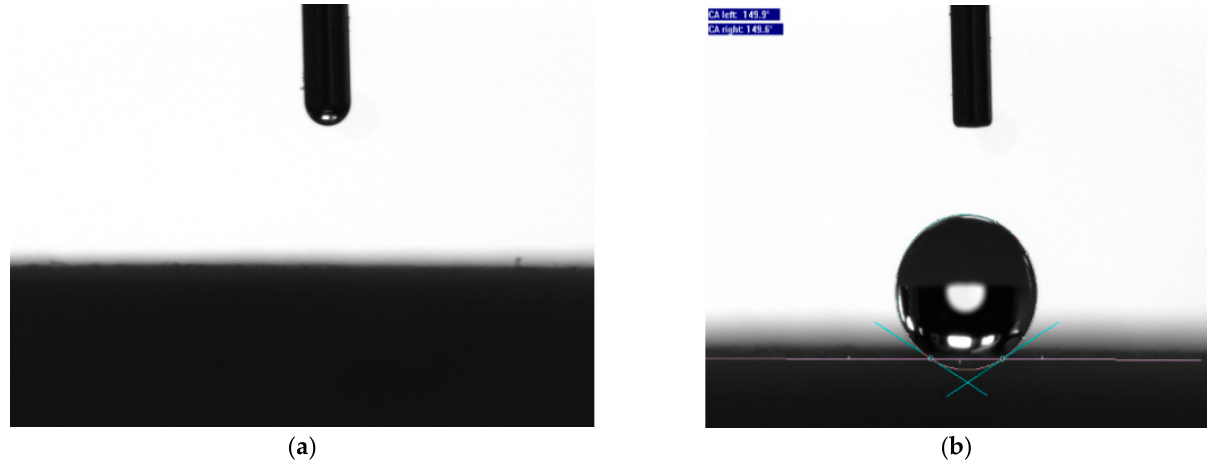
Figure 4. The w ater contact angle of ( a ) MS; ( b ) MS@PVC@SiO 2 . Figure 4. The water contact angle of ( a ) MS; ( b ) MS@PVC@SiO